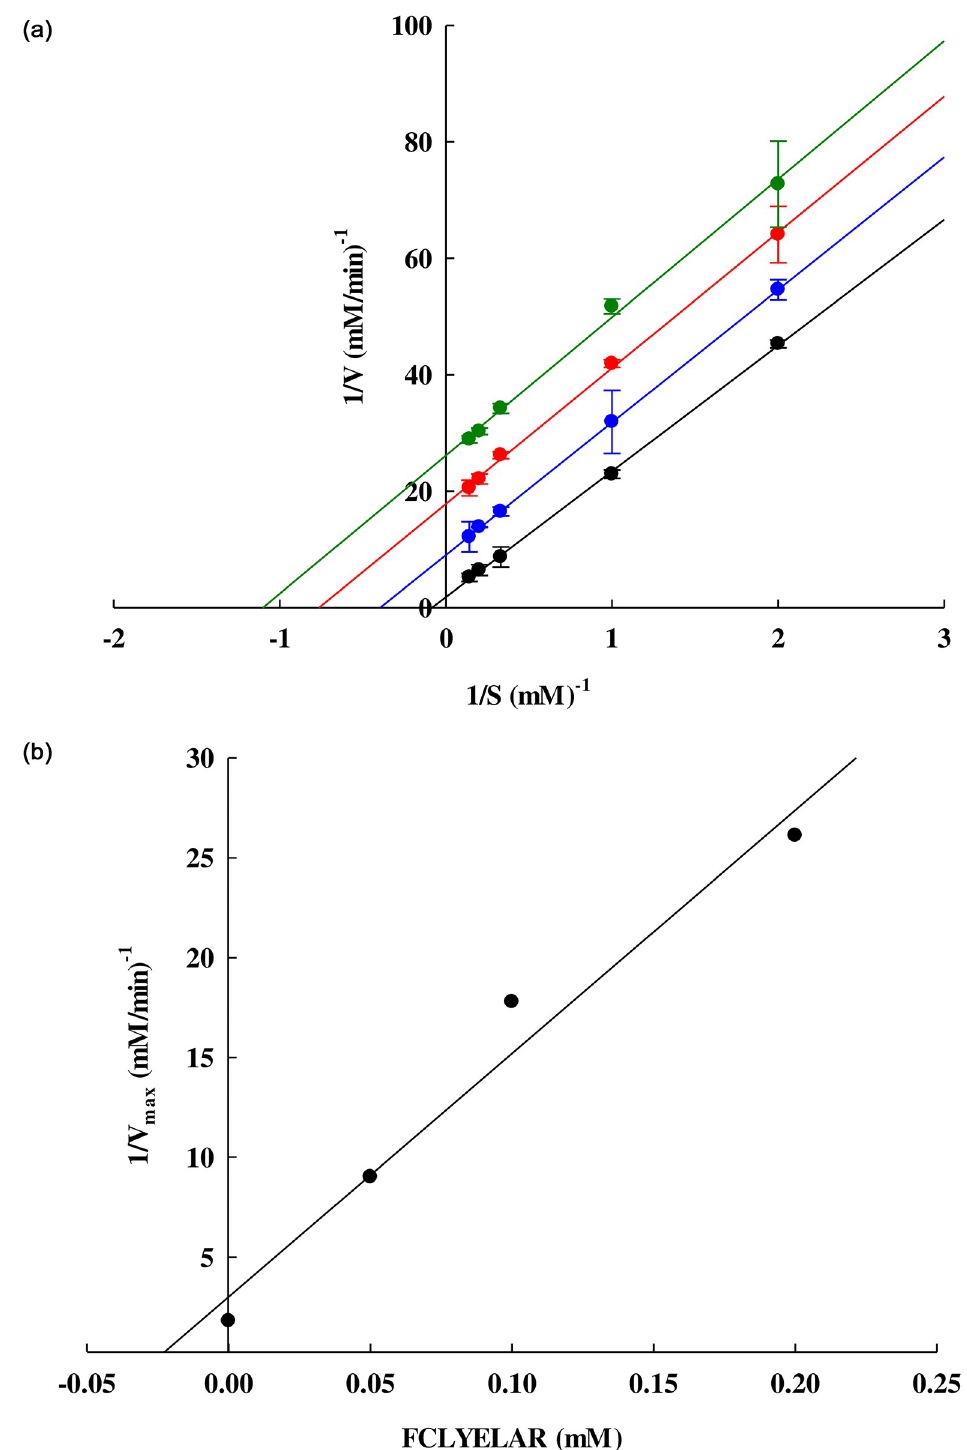
Fig 6. (a) The Lineweaver-Burk plot illustrating the influence of FCLYELAR uncompetitive inhibition upon ACE. The ACE-inhibitory activities were assessed when various concentrations of FCLYELAR peptide were present or absent ( ● , control; � , 0.05 mM; � , 0.1 mM; � , 0.2 mM). 1/V and 1/S are the respective reciprocals of the velocity and substrate. Each of the points is presented in the form of mean value ± Std. Deviation with tests performed in triplicate, and (b) the secondary plots showed the determination of the inhibitor constant (K i ) in the case of the uncompetitive inhibition by FCLYELAR.